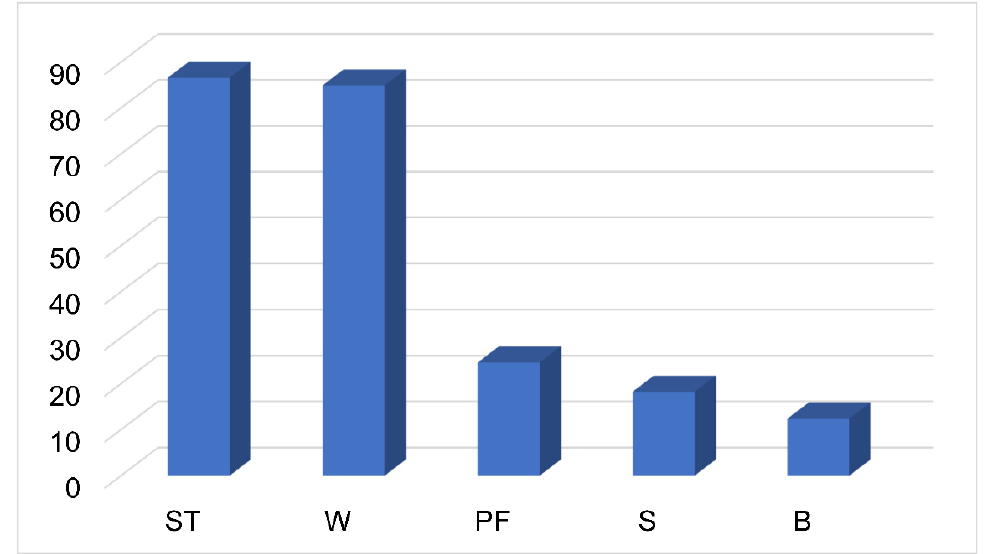
Figure 10. Sensitivity analysis results for input parameters.